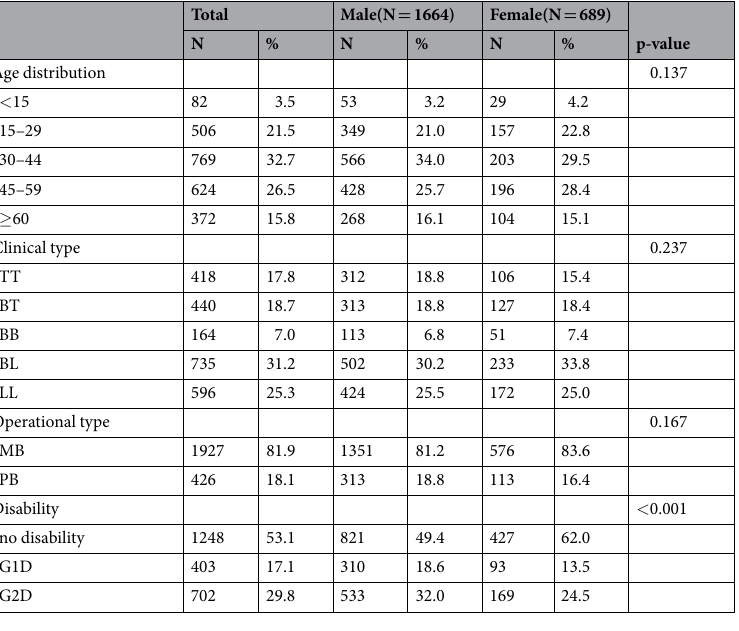
Table 1. Clinical characteristics between different gender groups. Note: Clinical and operational types of the leprosy patients. TT: tuberculoid; BT: borderline-tuberculoid; BB: mid-borderline; BL: borderline-lepromatous; LL: lepromatous; MB: Multibacillary; PB: Paucibacillary leprosy. Disability of the leprosy patients. ND: no disability; G1D: grade 1 of disability; G2D: grade 2 of